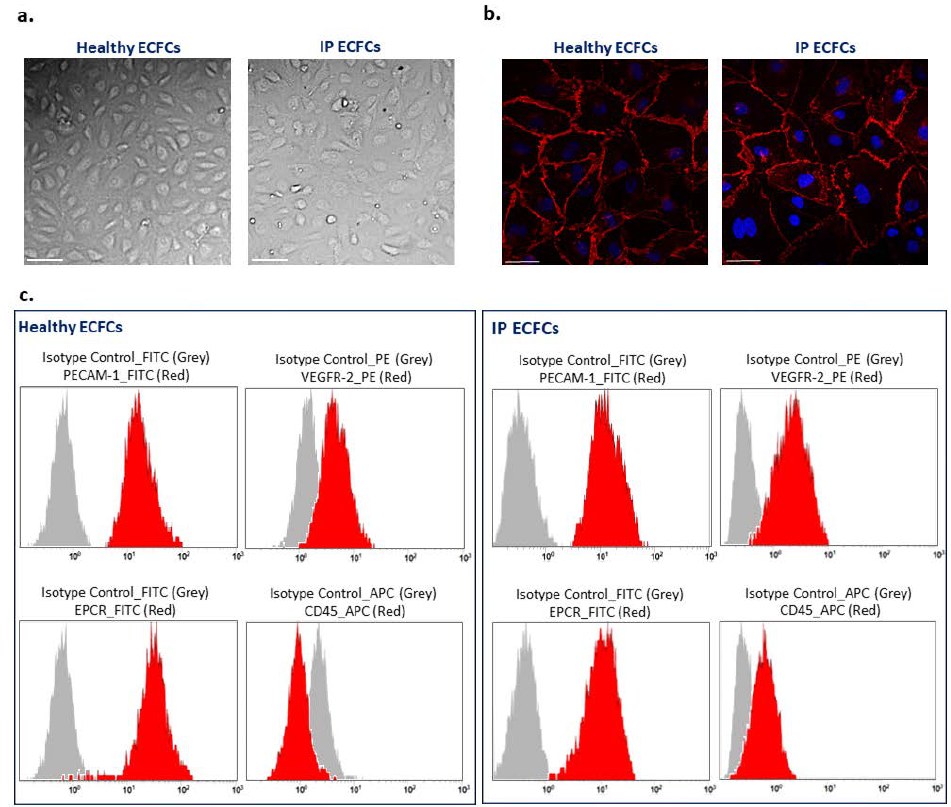
Figure 2. Phenotype characterization of endothelial colony-forming cells (ECFCs). ( a ) Typical endothelial cobblestone-like morphology of ECFCs isolated from a healthy individual and the index patient (IP) observed using bright-field microscopy. Scale bars, 100 µ m. ( b ) Expression of VE- cadherin (red) at cell–cell junctions is visualized with immunostaining of ECFCs derived from a healthy individual (left side) and patient (IP ECFCs) (right side). The nucleus is stained with DAPI (blue). Scale bars, 50 µ m. ( c ) Flow cytometry analysis of ECFCs derived from a healthy donor (left images) and the IP (right images). The data confirmed that both healthy and IP isolated cells were positive for endothelial cell canonical markers of PECAM-1 (CD31-FITC conjugated), VEGFR-2 (PE-conjugate), and EPCR (FITC-conjugate); besides, they were negative for leukocyte cell marker CD45 (APC-conjugate). Isotype controls were conjugated with either FITC, PE, or APC corresponding to their relevant antibodies, and they are shown as grey bell curve